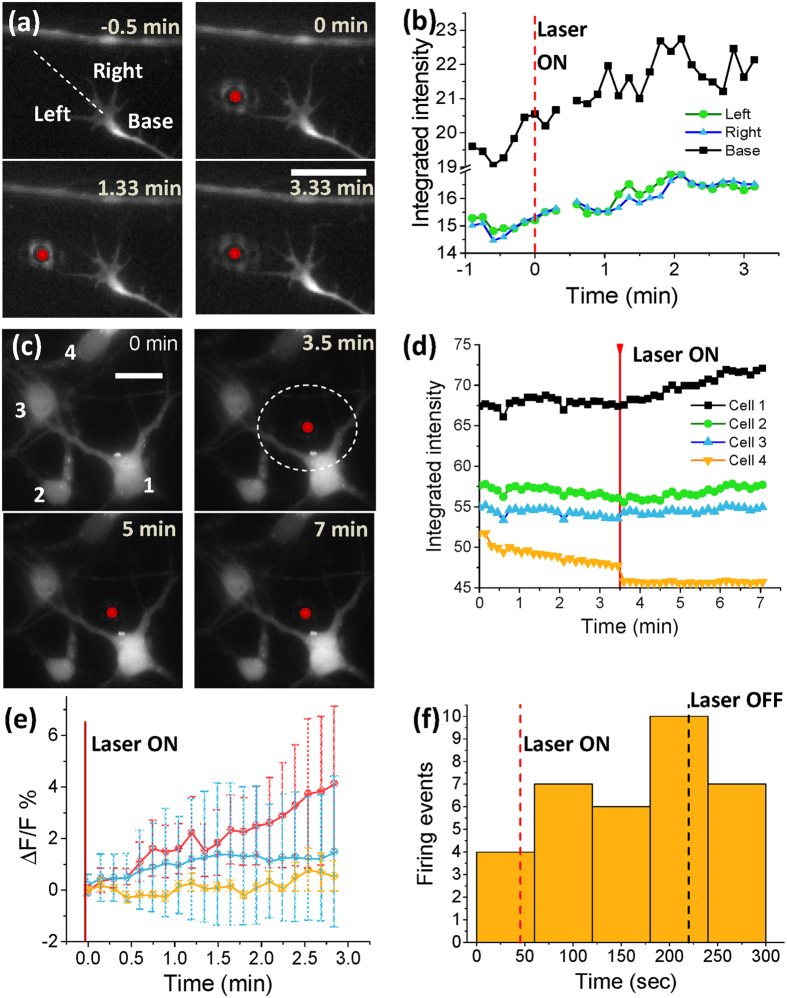
Calcium imaging of growth cone and soma of rat cortical neurons in response to NIR laser spot at-a-distance.(a) Representative epifluorescence time-lapse images of cortical neuron growth cone incubated with Fluo-3 AM (5 μM) and exposed to 1064 nm (10 mW) focused (1.3 NA) laser spot at-a-distance (marked by red dot). Left, right, and base of the growth cone shown in first panel. Scale bar: 10 μm. (b) Dynamics of fluorescence intensity integrated over three regions of interest (left, right, and central base) within the growth cone in response to laser spot at-a-distance. (c) Time-lapse fluorescence images of four cortical neurons (denoted by 1–4) incubated with Fluo-3 AM (5 μM) and exposed to 1064 nm (10 mW) focused (1.3 NA) laser spot at-a-distance (marked by red spot). (d) Dynamics of fluorescence intensity integrated over ROIs of equal area in the soma of the four cortical neurons before and after exposure to laser spot. Laser-on time indicated with red line. (e) Kinetics of fractional percentage change in integrated fluorescence intensity (ΔF/F %) for ROIs in cortical neurons in response to laser spot (1064 nm, 10 mW, 1.3 NA) for three different neuronal regions from the laser spot (distance: 0–10 μm, red; 10–20 μm, blue; >20 μm, orange). The dotted circle in panel c represents region within distance of 0–10 μm from the laser spot. N = 11. Average ± S.D. (f) Change in firing rate (measured by calcium fluorescence spikes) in response to laser spot at-a-distance (10 mW, 1000 nm).